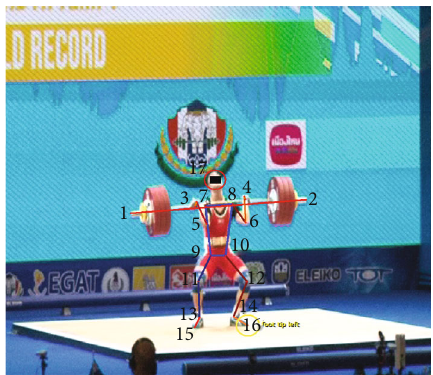
Figure 3: Seventeen key points on the human body and barbell manually